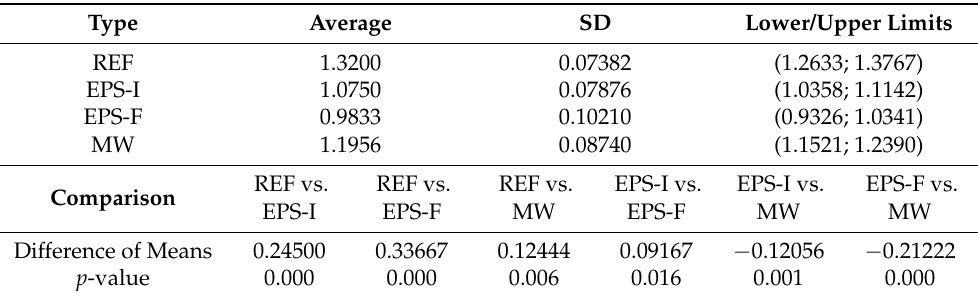
Table 18. Comparison for thermal conductivity (W/mK) between mortars with incorporation of the different thermal insulation materials.